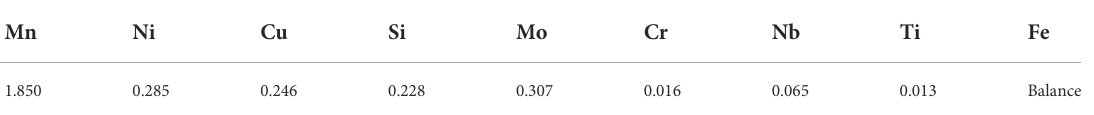
TABLE 1 Elemental composition of X80 steel (mass%).